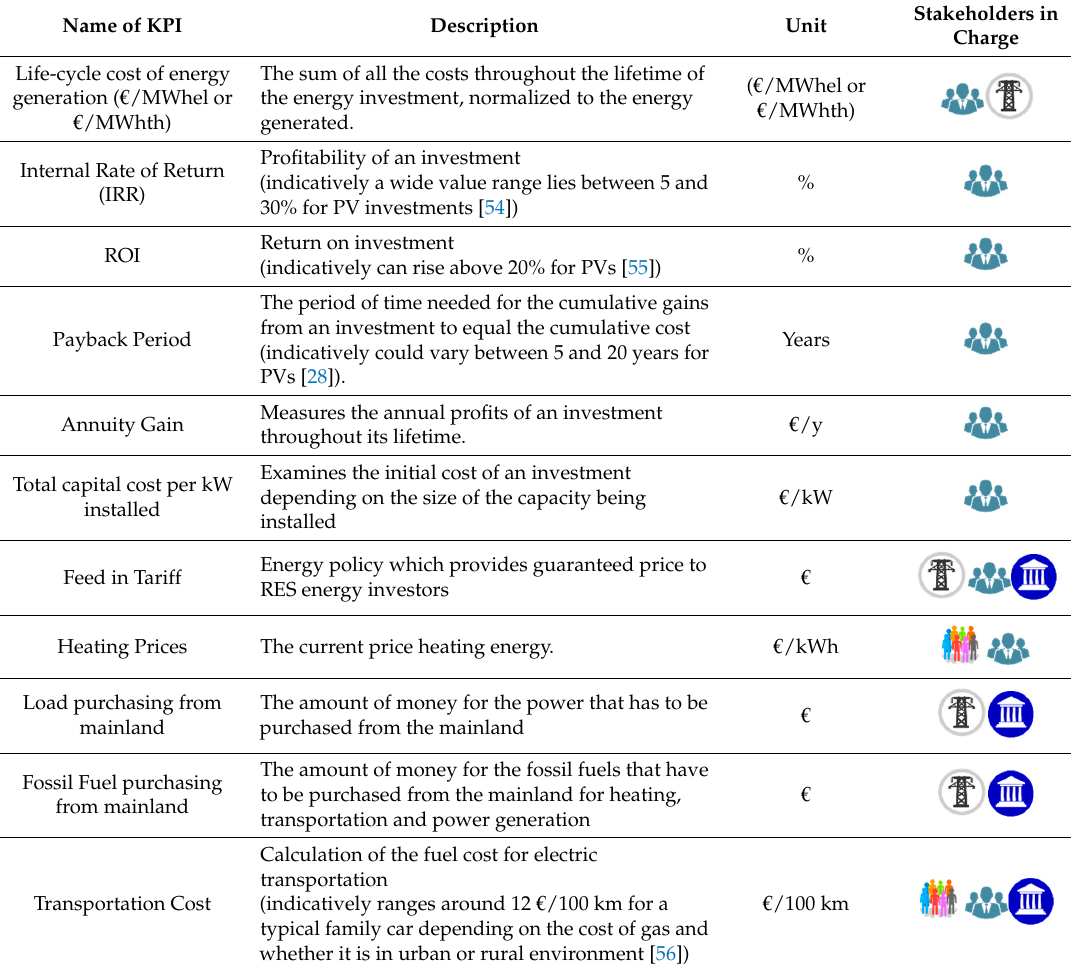
Table 7. List of Social KPIs.